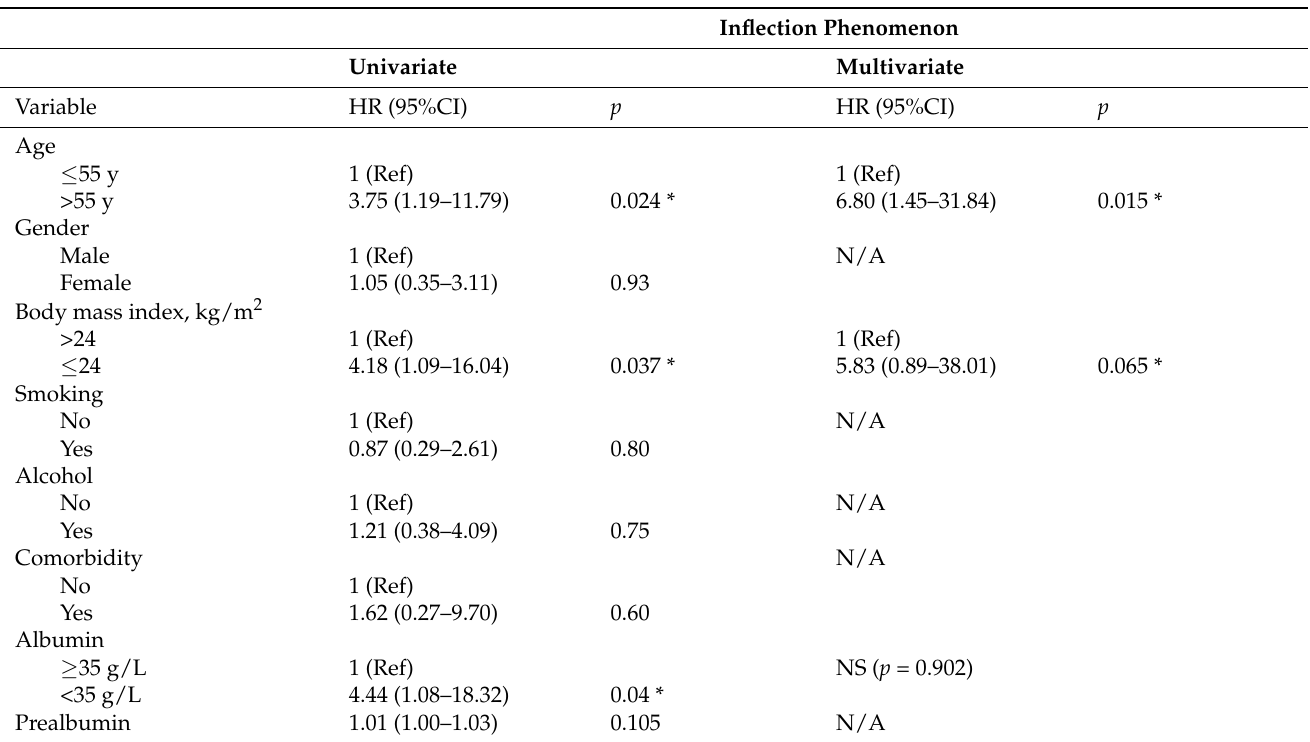
Figure 3. Representative figures for patients with inflection-point phenomenon. ( A – F , 6 patients from the IPN group). x axis indicates perioperative day, y axis (left) indicates oral epithelial cell apoptosis rate (%), and y axis (right) indicates total energy intake (Kcal). Table 3. Univariate and multivariate logistic regression analyses of factors associated with the inflection phenomenon ( n =